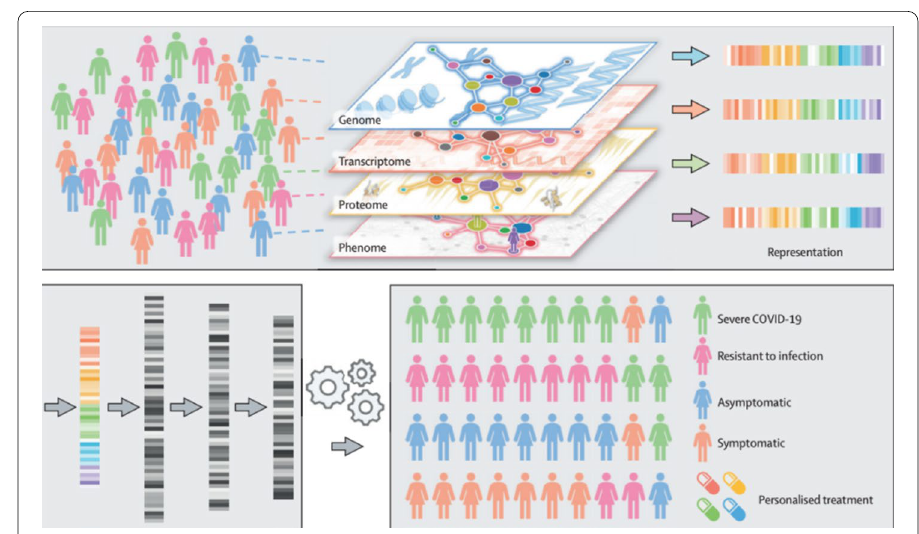
Fig. 14 AI for Precision Medicine (Image taken from Zhou et al.